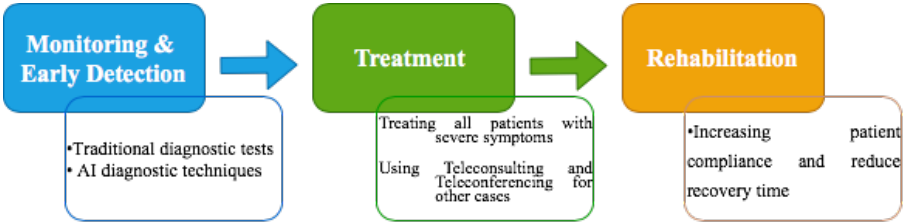
Figure 1. Three phases for healthcare systems in the battle against